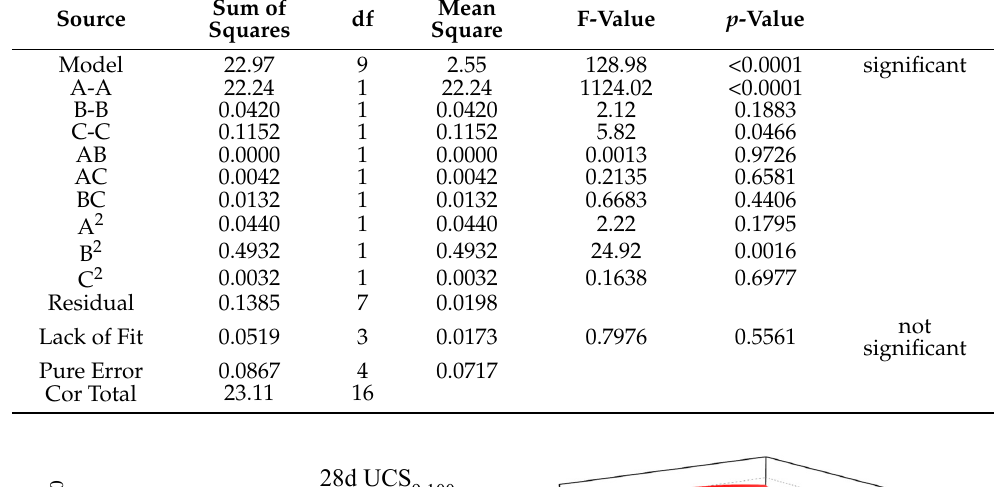
Table 8. Analysis of variance.